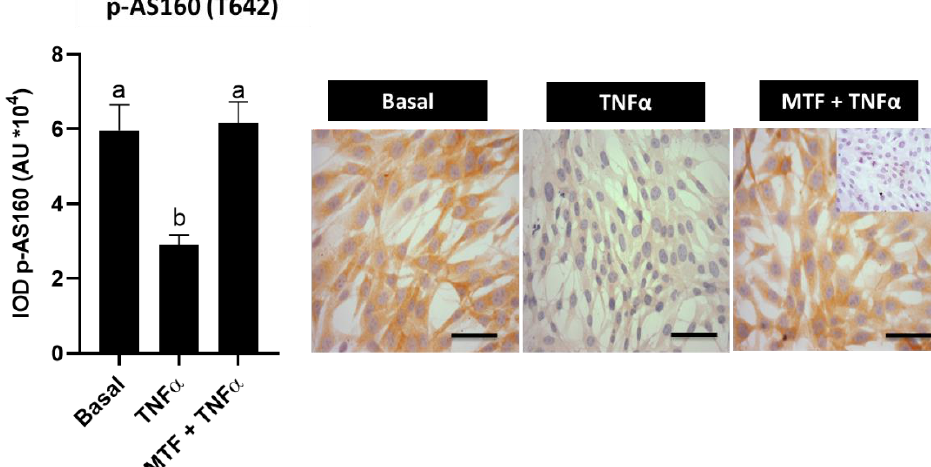
Figure 4. Effect of metformin on the expression of phosphorylated AS160 molecule in human endometrial cells exposed to TNF α treatment. p-AS160 (T642) protein levels in human endometrial cells treated for 24 h with TNF α (100 ng/mL) with or without metformin (MTF, 20 nM) by immunocytochemistry (ICC). Photomicrographs show the tissue location of p-AS160 by immune-positive brown color staining in each sample. The graphs show the semi-quantification obtained by the IOD tool. Inner box: negative control; bar = 50 µ m; images at 400 × (in (A): image of 200 × in inner box). Three independent experiments were performed for each treatment ( n = 3; in duplicate). In the graph, a ≠ b indicates a statistically significant difference with a p -value < 0.05; non-parametric test and Dunn’s post hoc test. Data are shown as mean AU (arbitrary units *10 4 ) ± SEM.